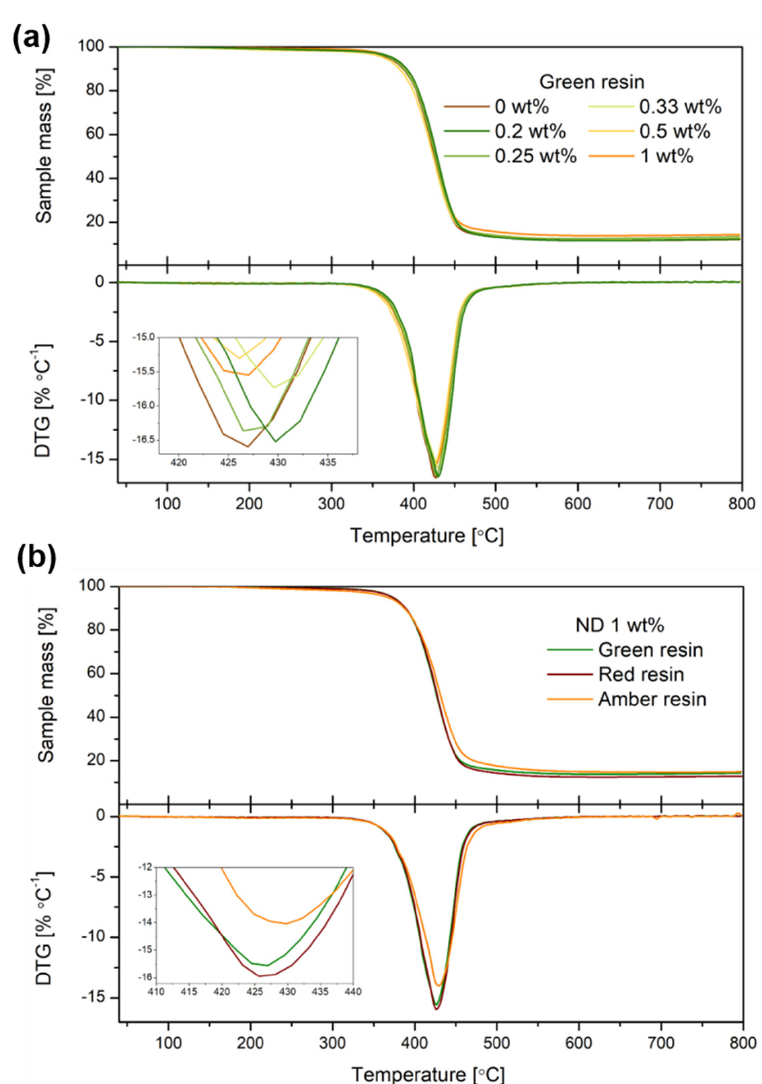
Figure 4. TG and DTG curves of MDPs–polymer composites with ( a ) green resin and ( b ) all samples with 1 wt.% (0 wt.% in Figure 4a belongs to the pure polymer without MDPs). Table 2. TGA results of MDPs–polymer composites: TD—degradation temperature at which mass loss reaches 5%, T max —temperature corresponding to a maximum rate of decomposition, mr— weight percentage of the residue at 800 °C .